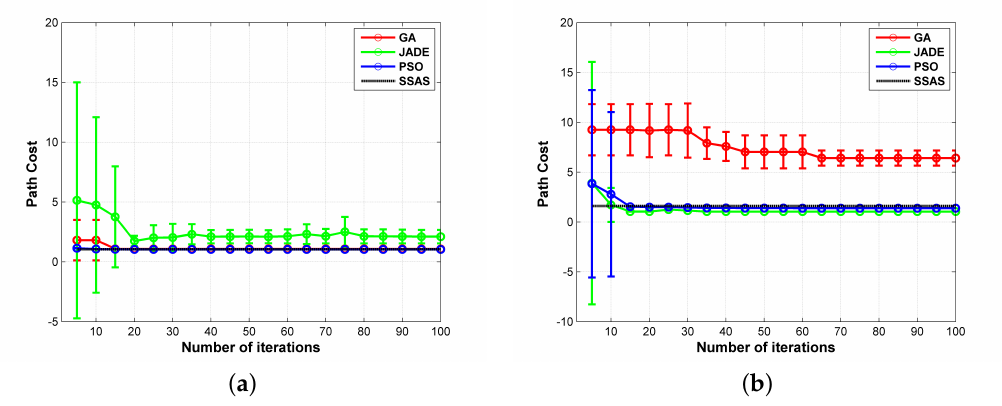
Figure 22. Convergence curves of the bio-inspired algorithms. ( a ) test case 1-s1; ( b ) test case 1-s4. Table 7. Performance comparison with the stochastic path planning